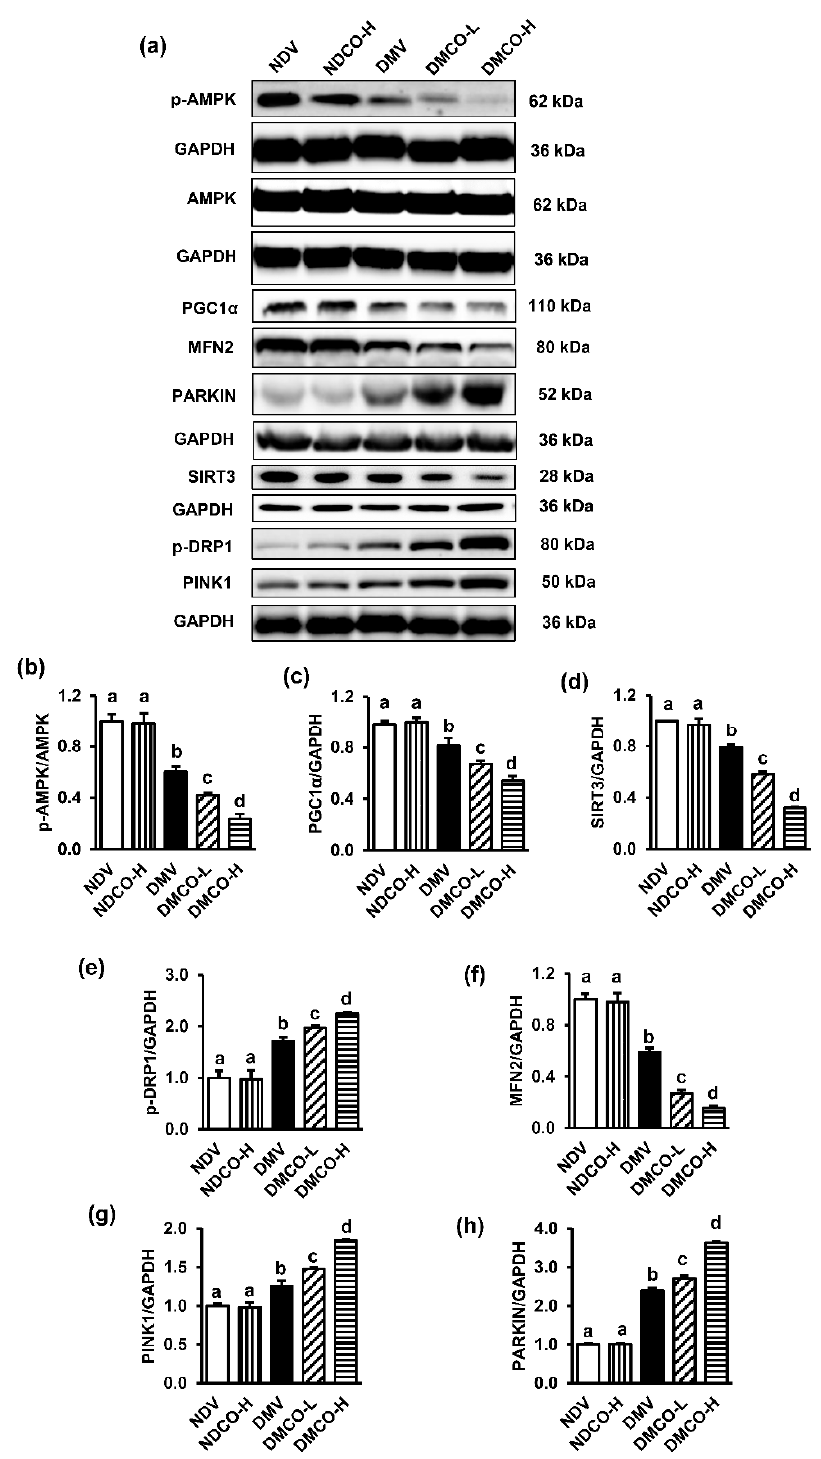
Figure 5. Effects of crocodile oil on the expressions of proteins involved in mitochondrial homeostasis: ( a ) representative images of Western blots; the quantitative analyses of ( b ) p-AMPK/AMPK, ( c ) PGC1 α , ( d ) SIRT3, ( e ) pDRP1, ( f ) MFN2, ( g ) PINK, and ( h ) PARKIN. Values are mean ± SEM (n = 3). NDV: nondiabetic treated with vehicle; NDCO-H: nondiabetic treated with high-dose crocodile oil; DMV: diabetic treated with vehicle; DMCO-L: diabetic treated with low-dose crocodile oil; and DMCO-H: diabetic treated with high-dose crocodile oil. Different lowercase letters denote statistical differences at p < 0.05 between groups.